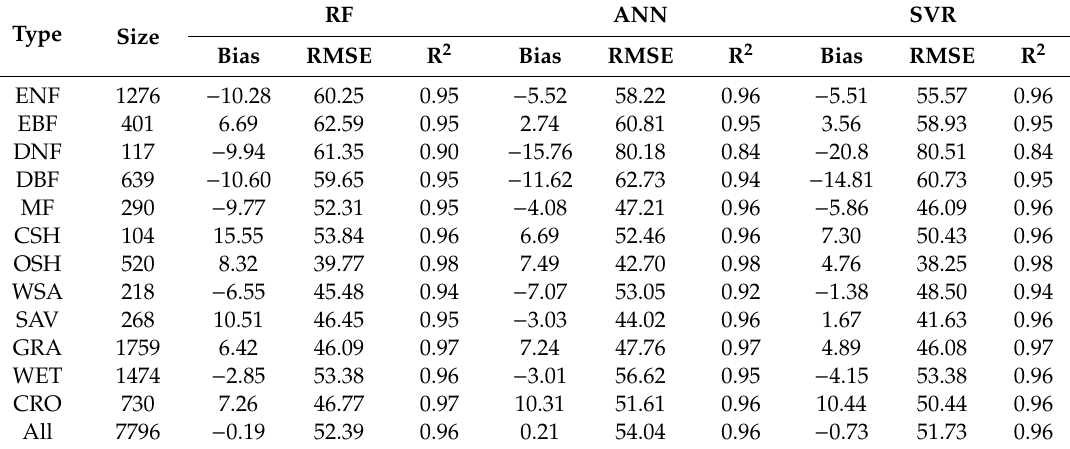
Table 3. Error statistics of NSSR retrieval using machine learning algorithms in di ff erent IGBP surface types.